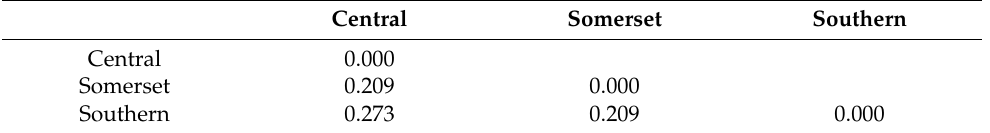
Table 4. Pairwise population F ST values (below diagonal) calculated using Wrights F -statistics between regional metapopulations of Santalum lanceolatum from Cape York (Queensland, Australia). Central Somerset Southern Central 0.000 0.000